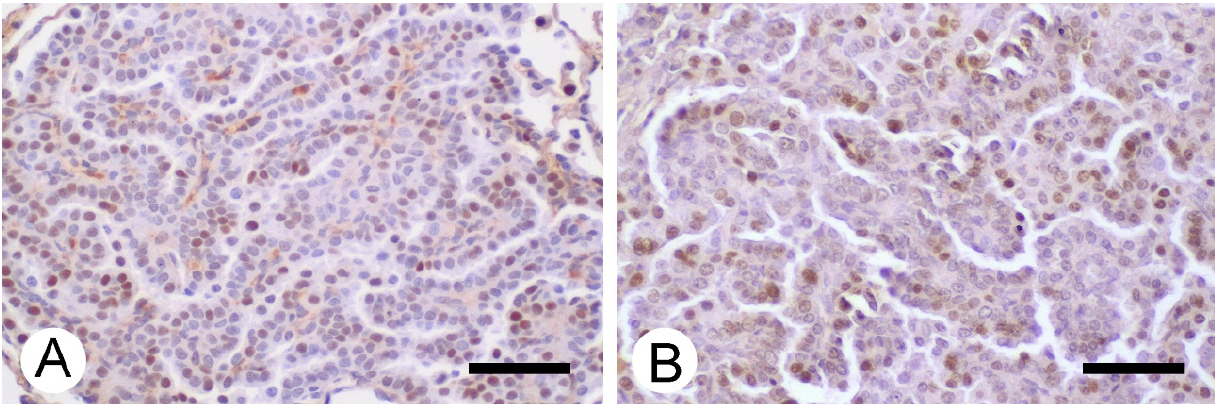
Figure 6. Immune stain for PCNA in lung adenomas. Positive PCNA nuclei (ochre color) were observed in urethane ( A ) and urethane-V ( B ) with no statistical difference between them. Hematoxylin counterstain. Bar 50 µm.